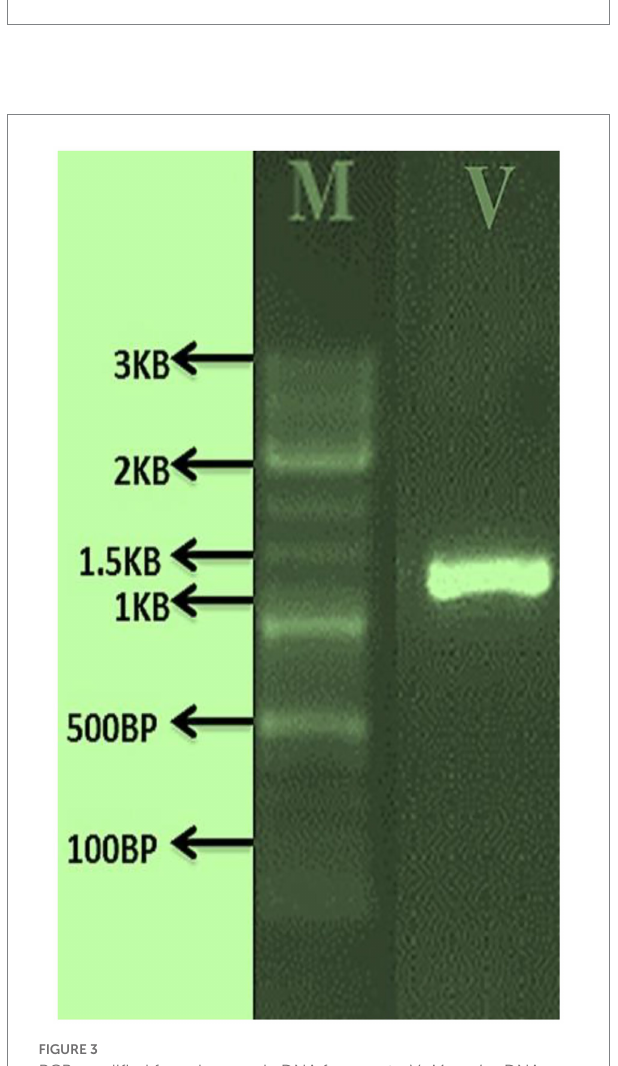
FIGURE 3 PCR amplified fungal genomic DNA fragments. V: M. majus DNA fragment size range is 1.3 KP, M: 3 KB